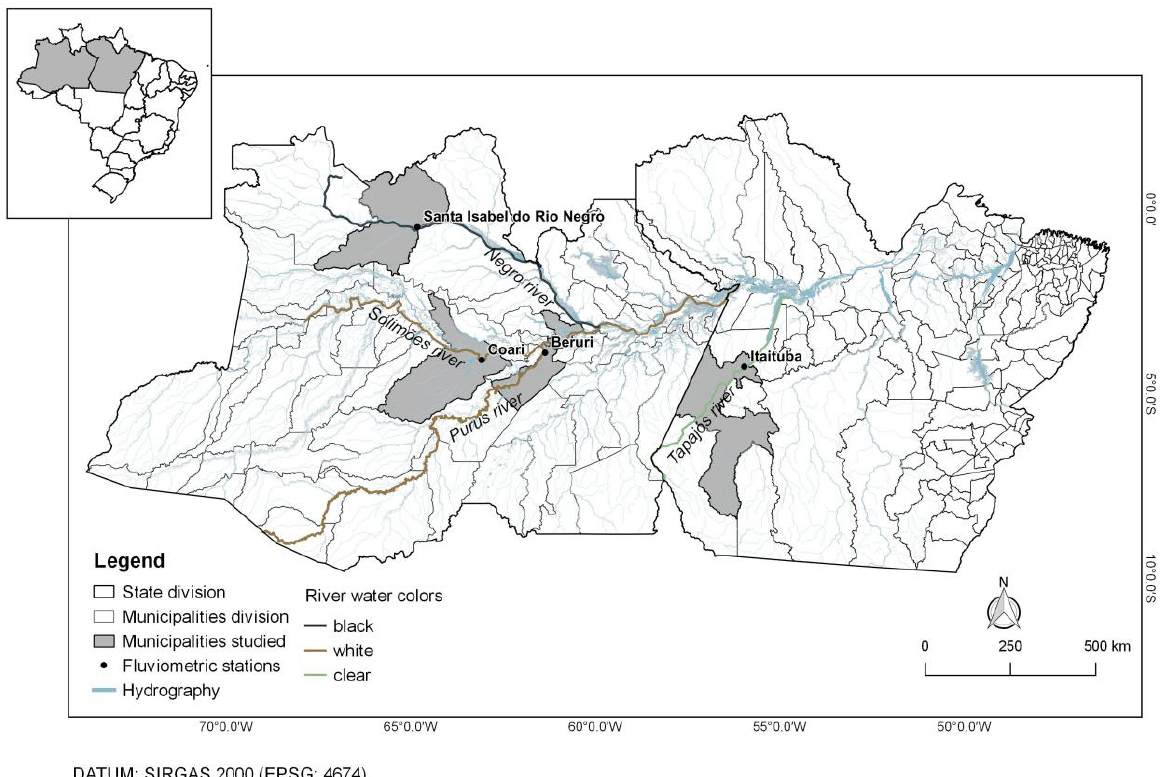
Figure 1. Area studied in the Amazon region: municipalities in the Amazonas state (Beruri, Coari, Santa Isabel do Rio Negro) and Pará state (Itaituba), which are located, respectively, on the banks of the Purus River (whitewater), Solimões River (whitewater), Negro River (blackwater) and Tapajós River (clearwater).